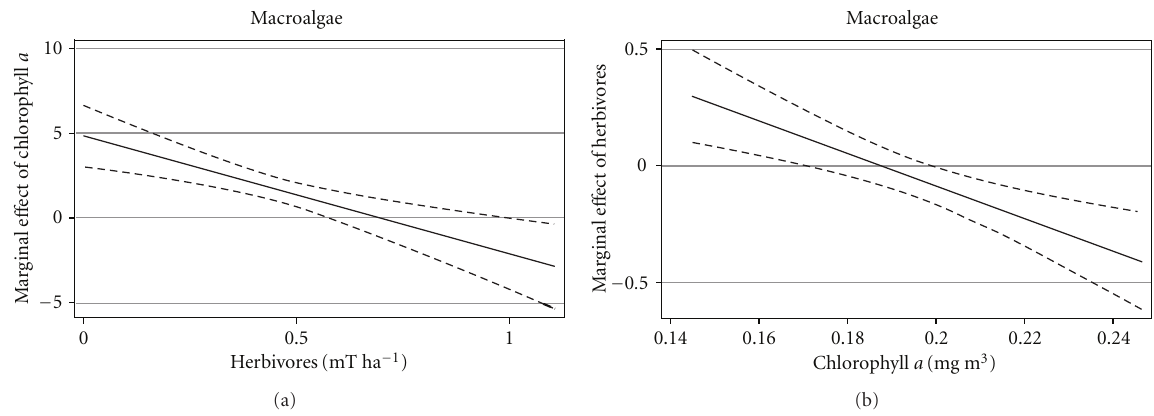
Figure 5: The marginal e ff ects of herbivores and chlorophyll- a on macroalgae. (a) The marginal e ff ect of chlorophyll- a on macroalgae as a function of herbivore biomass and (b) the marginal e ff ect of herbivores on macroalgae as a function of chlorophyll- a . Marginal e ff ects were estimated from the best fit model of macroalgae to herbivores, chlorophyll- a , and their interaction (see Tables S6 and S7). Dotted lines are 95% confidence